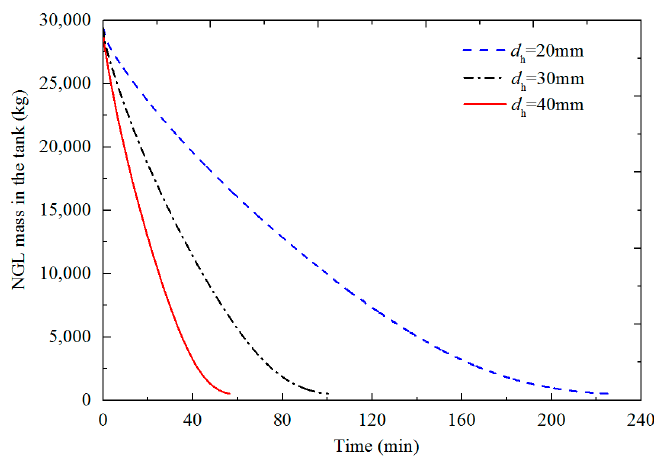
Figure 20. The residual NGL mass in the tank with different leak hole diameters.